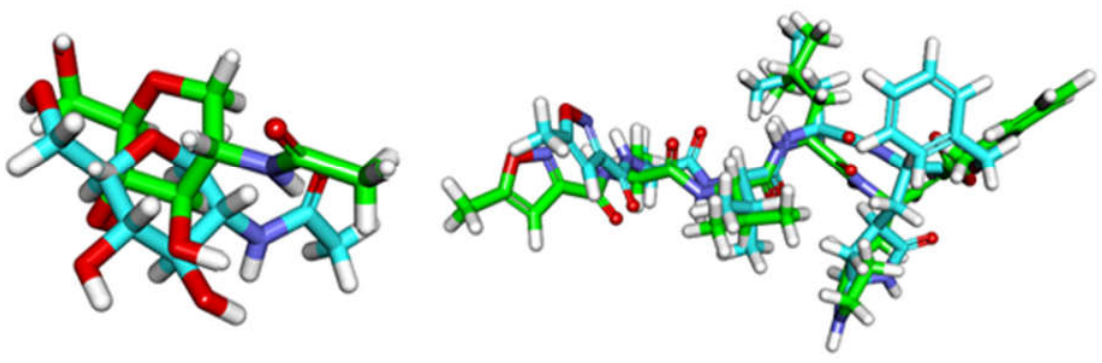
Figure 3. Superimposition of the co-crystallized poses (green) and the docking pose (maroon) of the same ligands. ( Left ): hACE2 (RMSD = 2.4 Å), ( right ): M pro (RMSD = 2.8 Å).